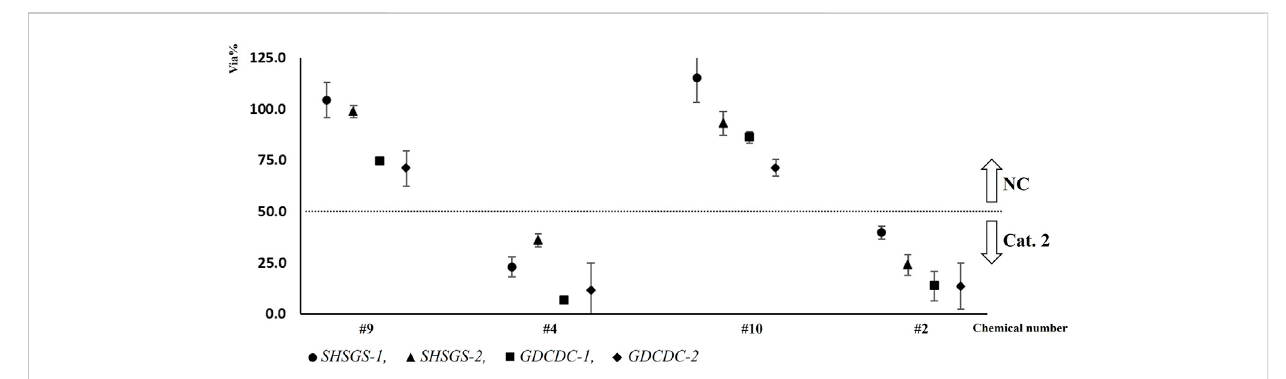
FIGURE 4 Distribution of mean cell viabilities for each run of test chemicals